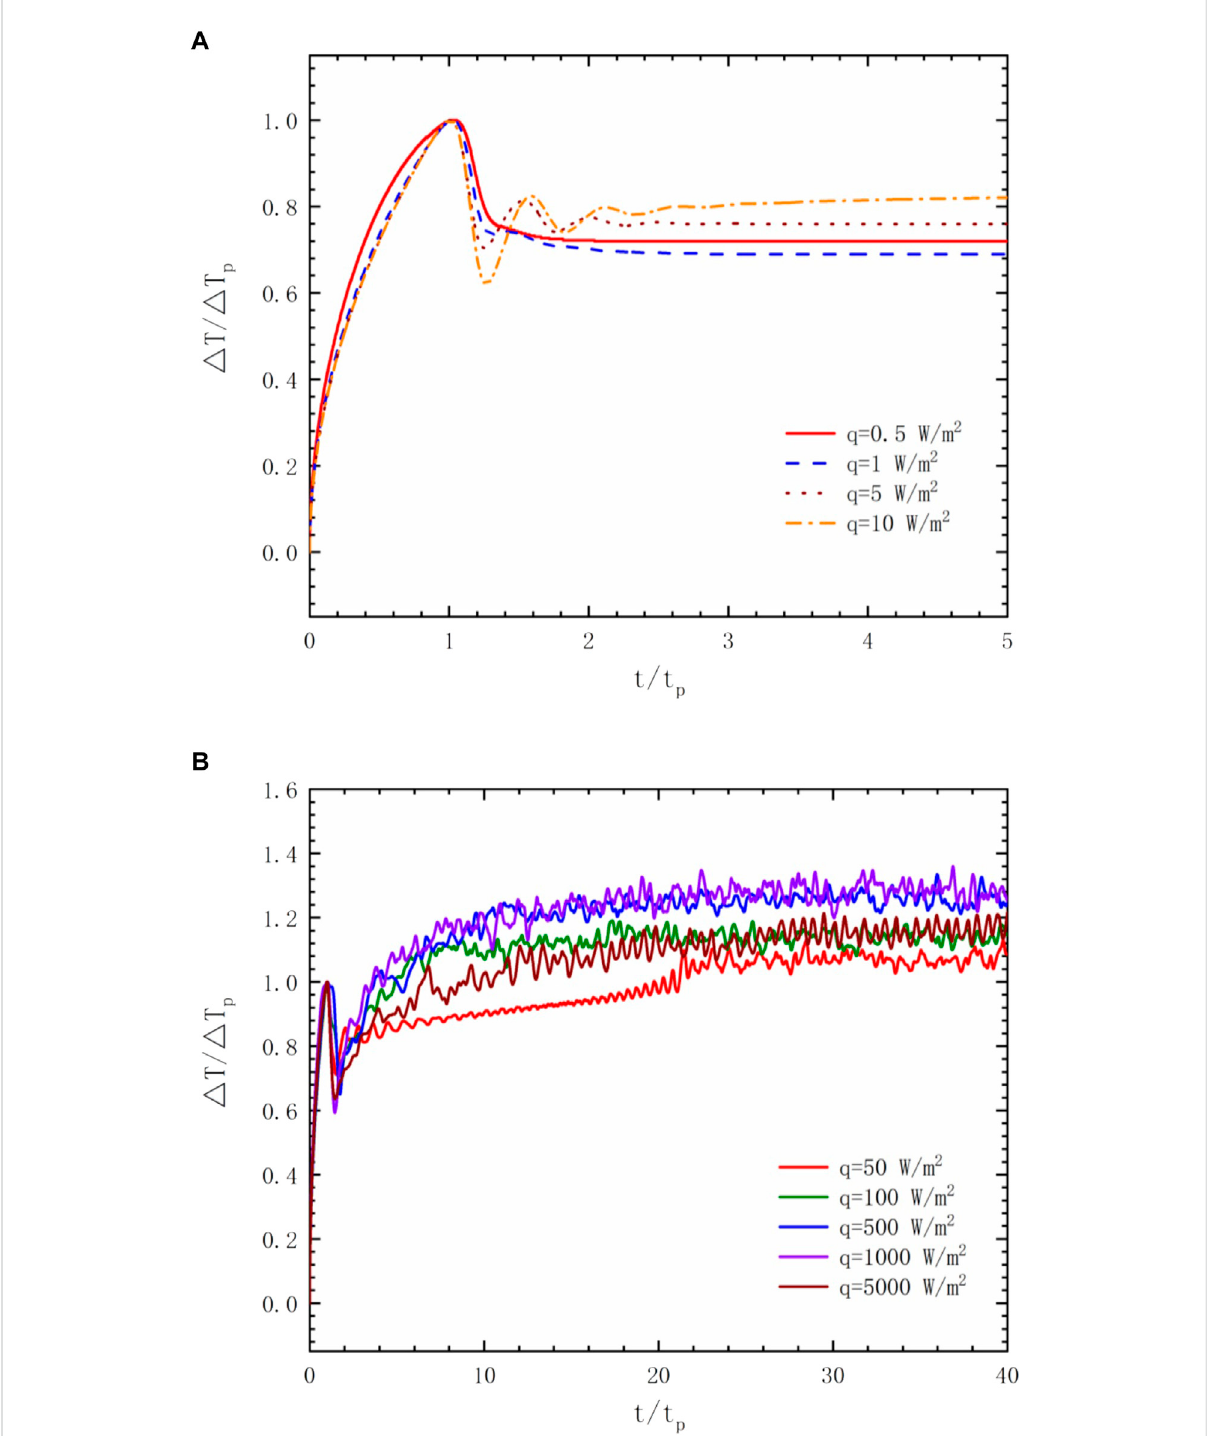
FIGURE 3 Variations of the horizontally averaged vertical temperature drop Δ T with the time evolution. (A) q = 0.5 — 10 W/m 2 . (B) q = 50 — 5000 W/m 2